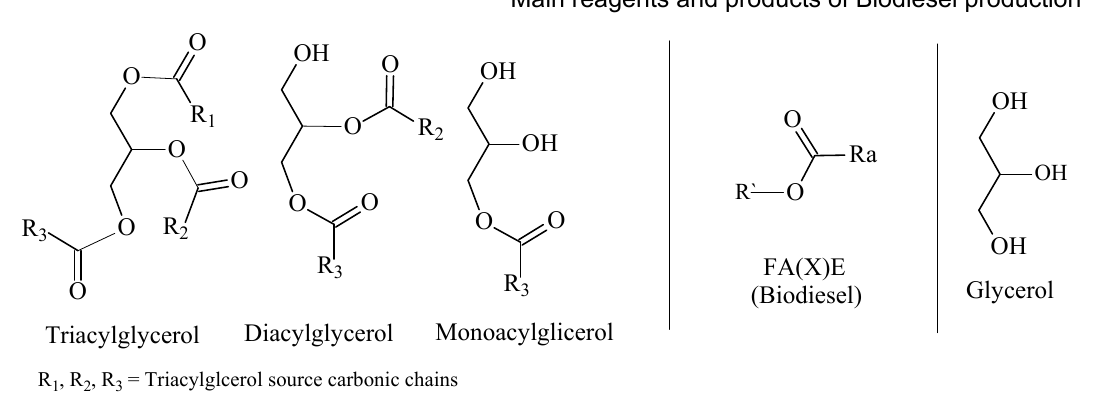
Figure 12. Molecular structures from Oligocat catalysts, reagents, and main products of biodiesel synthesis.